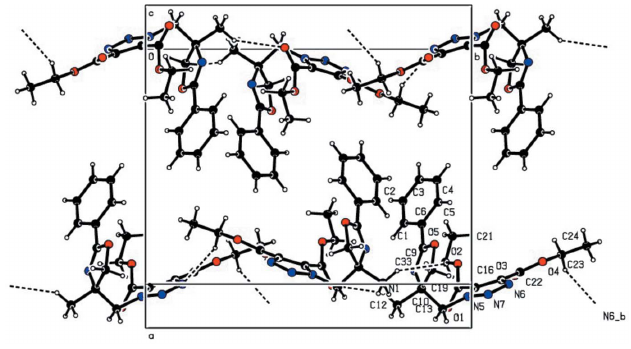
Figure 2 A view of the molecular packing along the c axis. Hydrogen bonds are drawn as dashed lines.